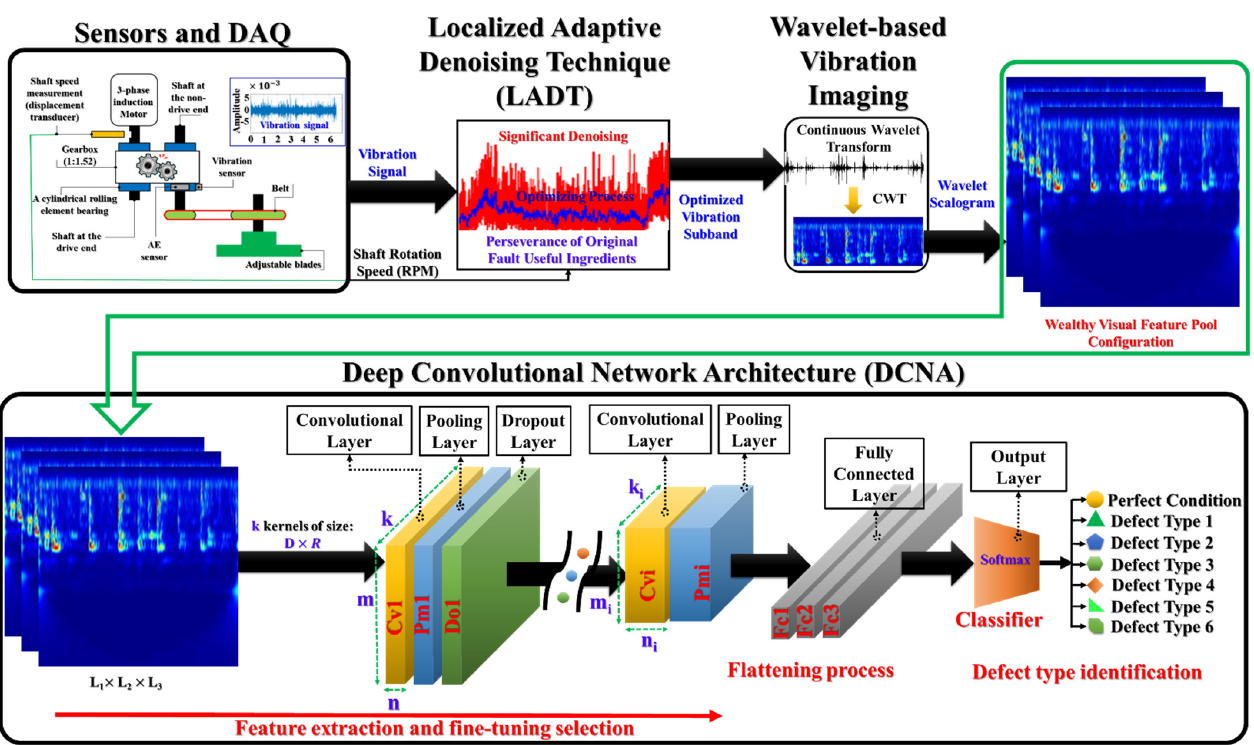
Figure 6. Block diagram of the proposed accurate and stable MDTF gear fault identification framework.